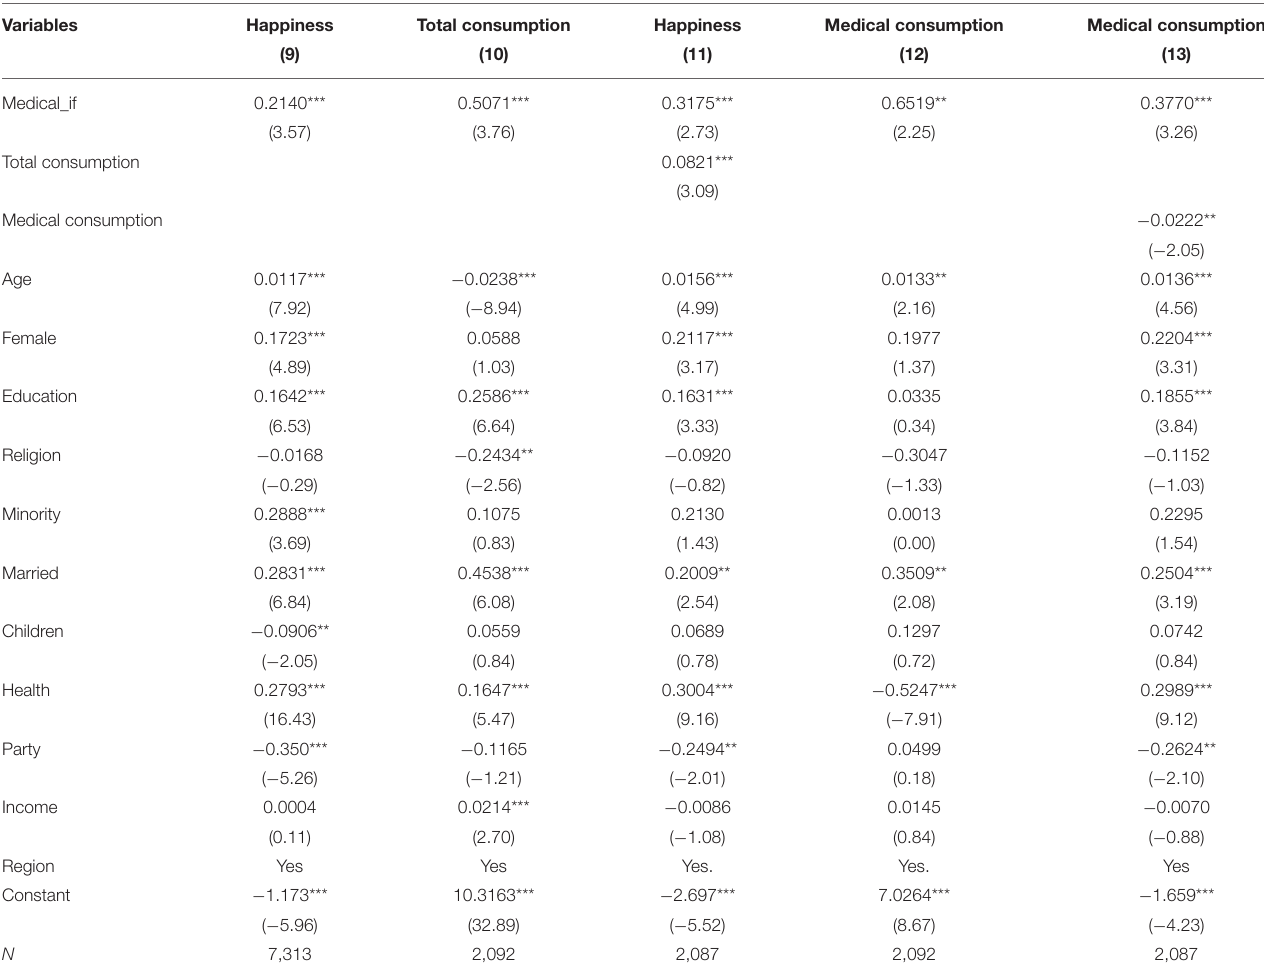
TABLE 6 | Results of mechanism